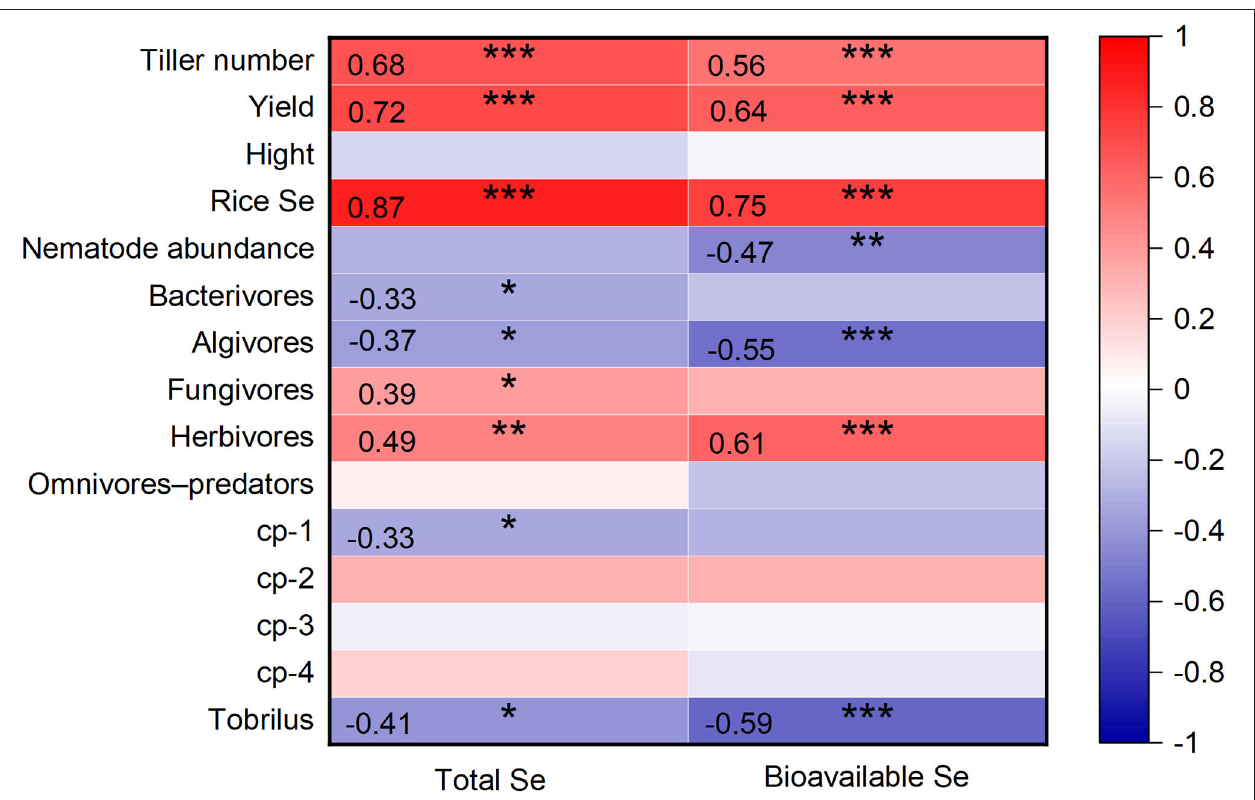
FIGURE 5 | Pearson correlations between the soil Se concentrations (total Se and bioavailable Se) with indexes of rice plant and soil nematodes ( n = 39). *, **, and *** indicate significant relationships at p < 0.05, p < 0.01, and p < 0.001 level,